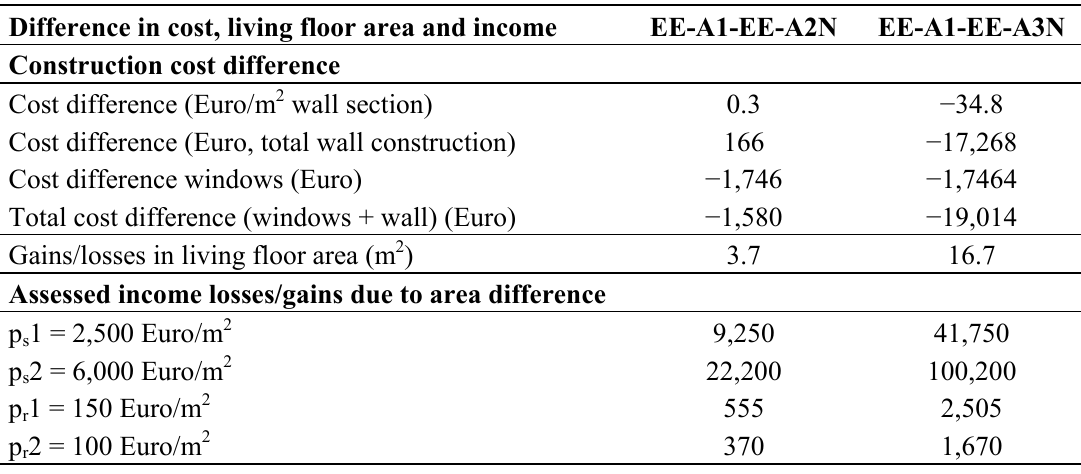
Table 11. Cost difference and assessed living area lost between energy-efficient and energy-efficient building constructed with new product, timber